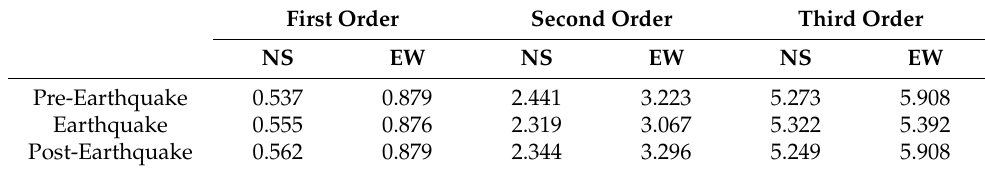
Table 4. Natural vibration frequency values before, during, and after the earthquake (Unit: